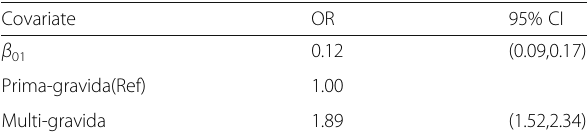
Table 8 Fixed effects and their 95% credible intervals (CI):